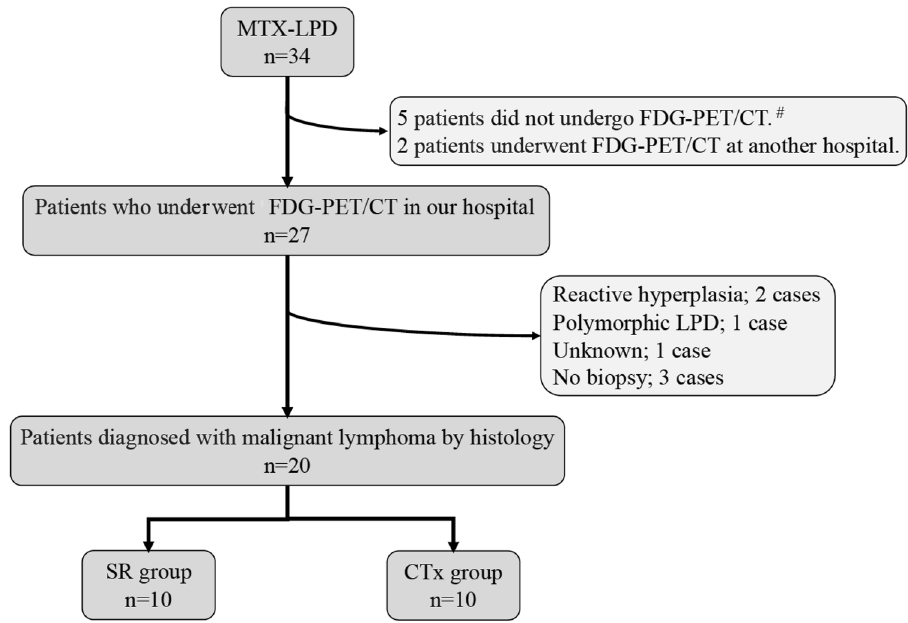
Figure 1. Patient selection flow chart. SR spontaneous regression, CTx chemotherapy. Hash: tumor rapidly regressed after discontinuation of MTX in four cases, whereas rapid growth occurred in one